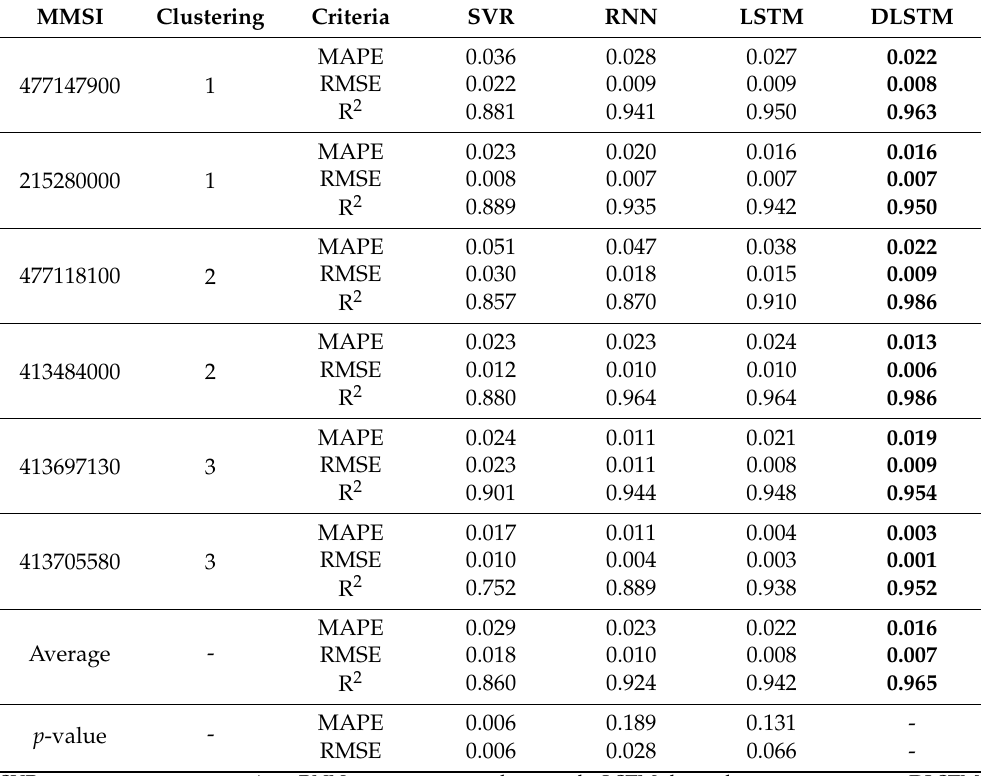
Table 6. Vessel trajectory prediction errors for different models for six